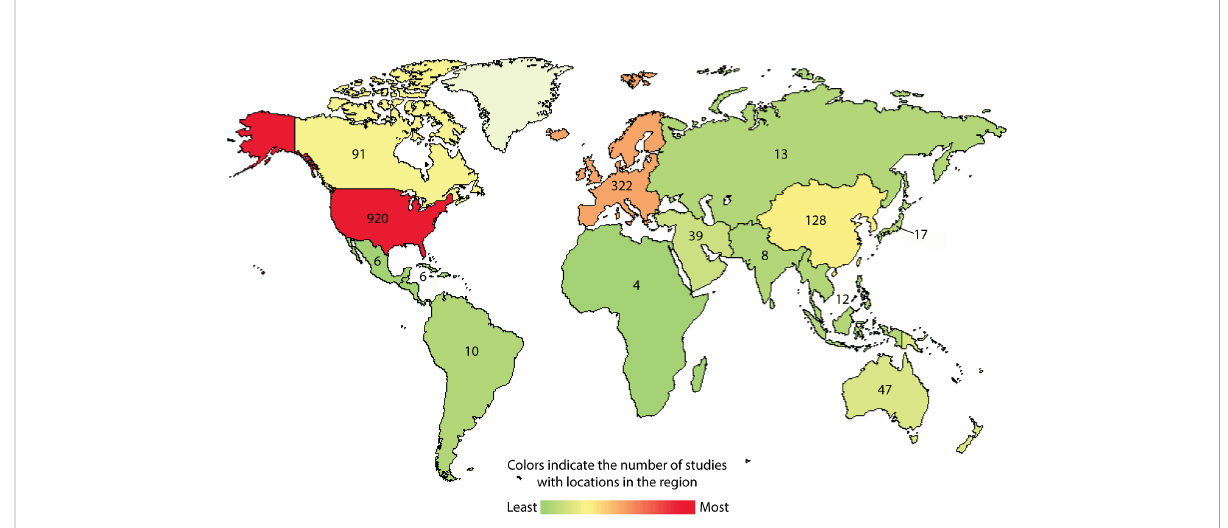
FIGURE 1 Current landscape for interventional immunotherapy clinical trials for GBM. Using clinicaltrials.gov/, condition or disease “ glioblastoma ” , type “ interventional studies ” and start study “ 01/01/2005 ” accessed on